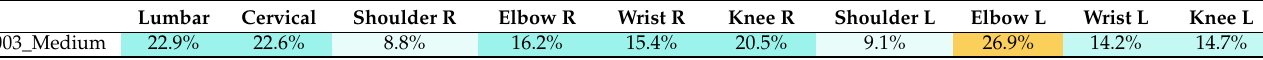
Table 10. Results of the P003 workplace example: RiskPerMinute